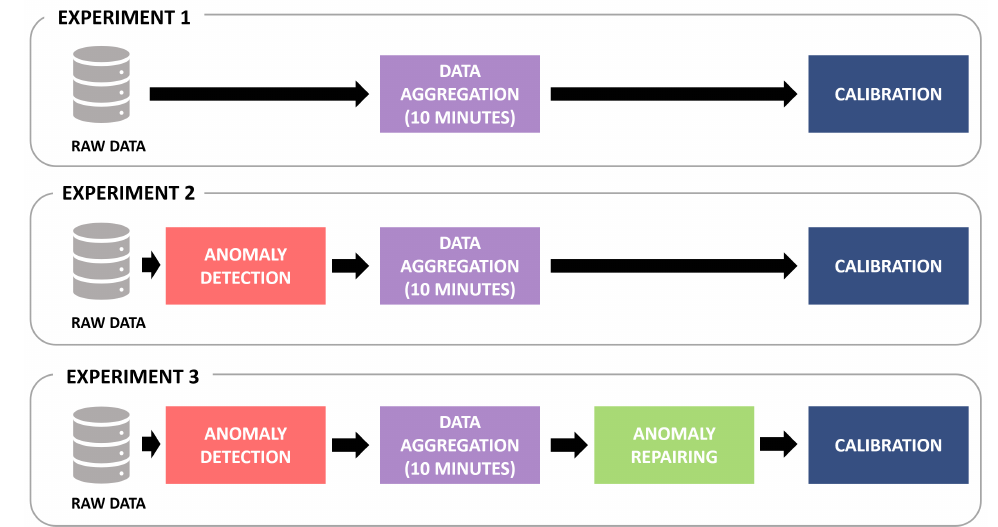
Figure 6. Description of the data flow in the proposed experiments. Exp1 : The 10 min of aggregated raw data were directly used to train the calibration models. Then, in the test phase, raw data were directly aggregated without excluding anomalies and then given as input to the calibration